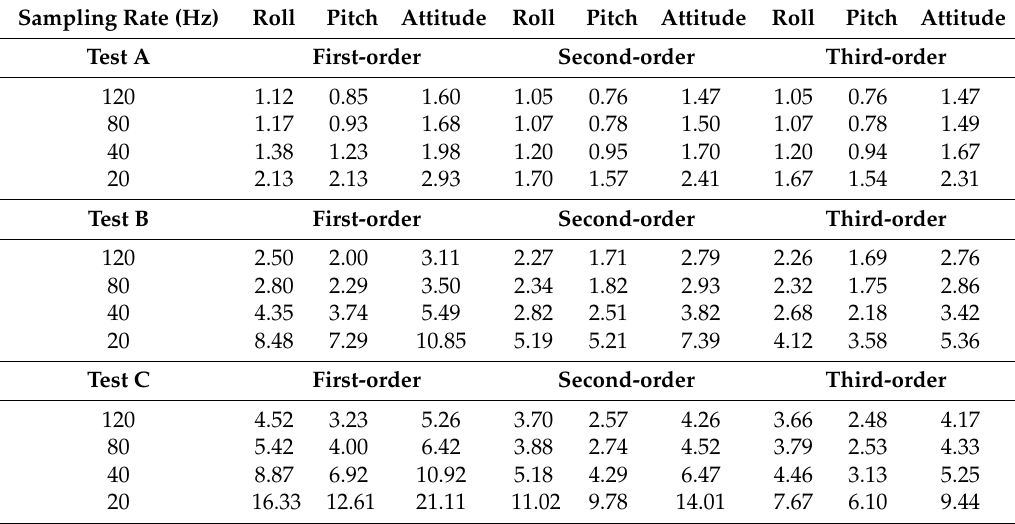
Table 1. Averaged root-mean-square error (RMSE) results for Case 1 (unit: ◦ ). Sampling Rate